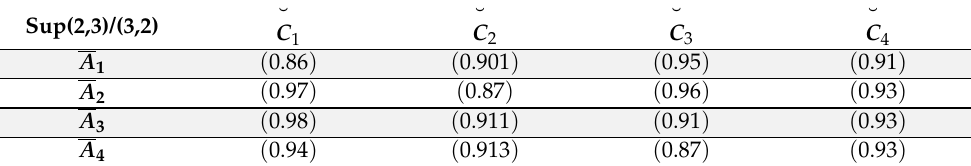
Table 6. Decision matrix of calculated support values established from Tables 2 and